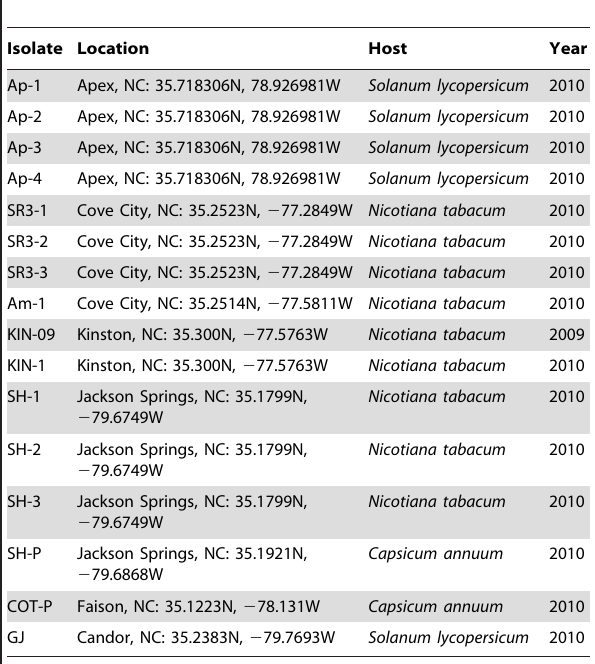
Table 2. Tomato spotted wilt virus isolate sample collection information.